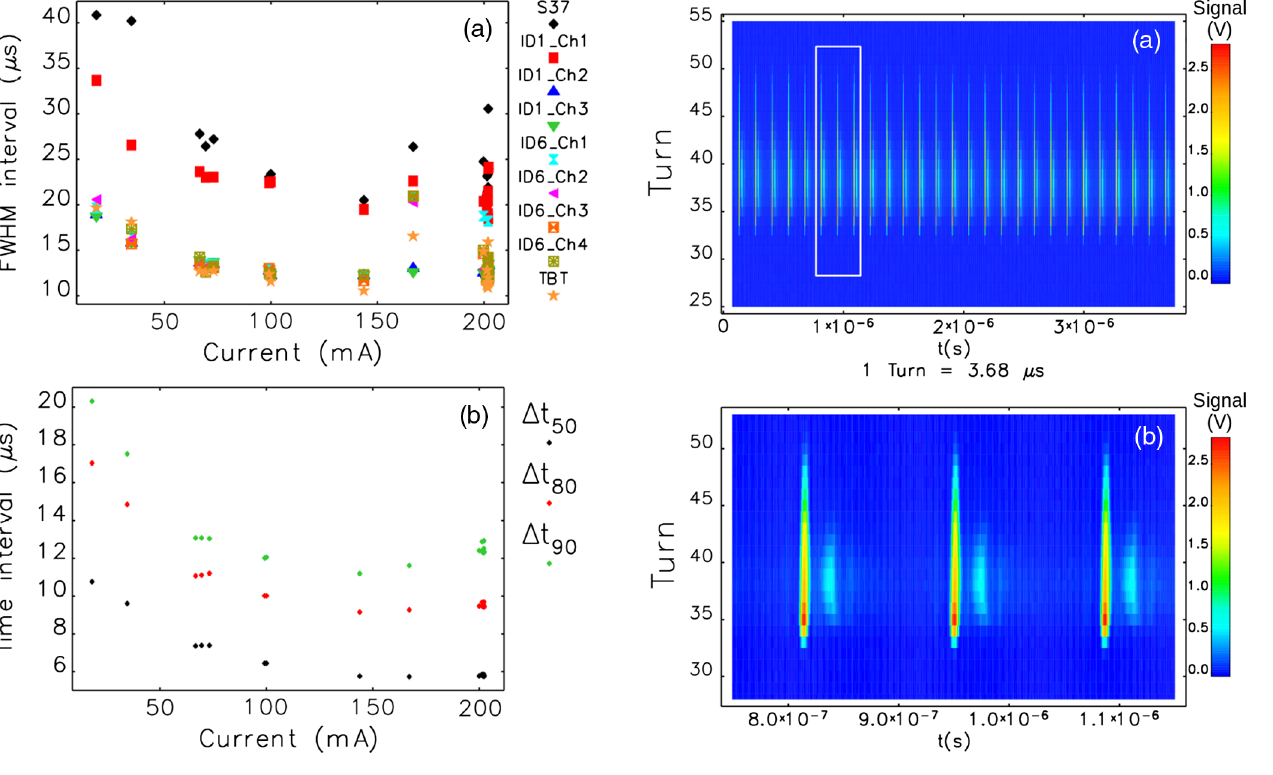
FIG. 34. Comparison of FWHM loss durations for all 20 beam dumps of the second experiment determined from (a) the fast BLMs and TBT BPMs and (b) PELEGANT simulations. PELEGANT results are presented for time required to lose 50, 80, and 90 percent of beam particles. The fast BLMs in ID1 are labeled ID1_ChM where M ¼ 1 ; 2 ; 3 and those in ID6 are labeled ID6_ChN where N ¼ 1 ; 2 ; 3 ; 4 . The fast BLM in S37 is simply labeled S37.